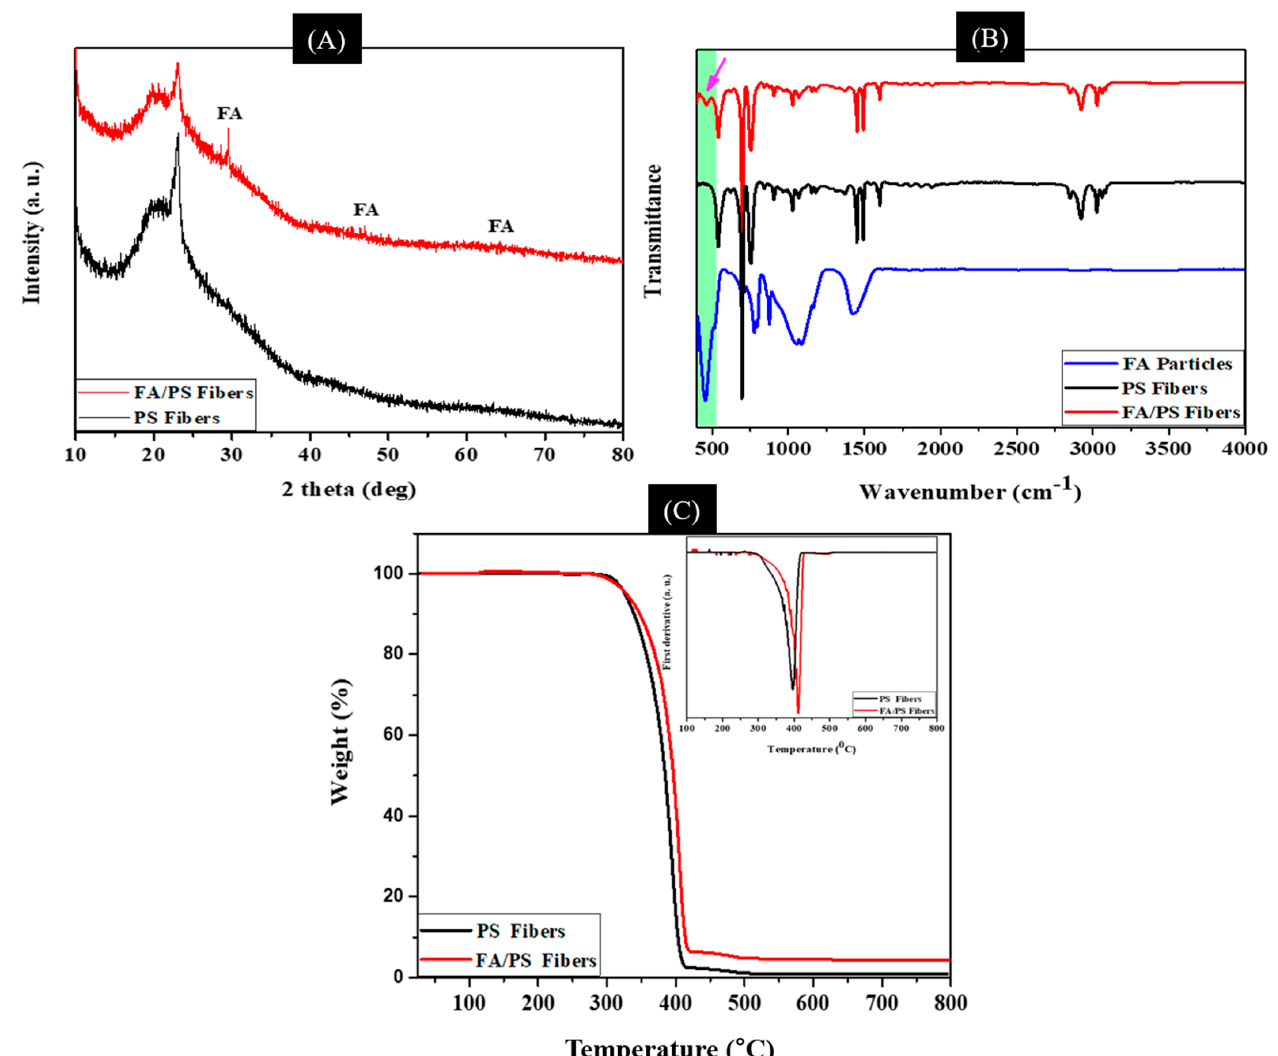
Figure 6. XRD ( A ), FTIR ( B ), and TGA ( C ) of as-prepared samples. The inset in C represents the DTG curves of FA/PS composite membrane compared to that of the pristine PS fibers.